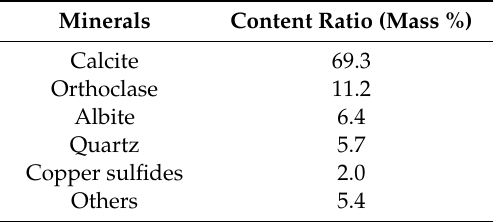
Table 3. Mineral composition of the Chilean copper ore sample.